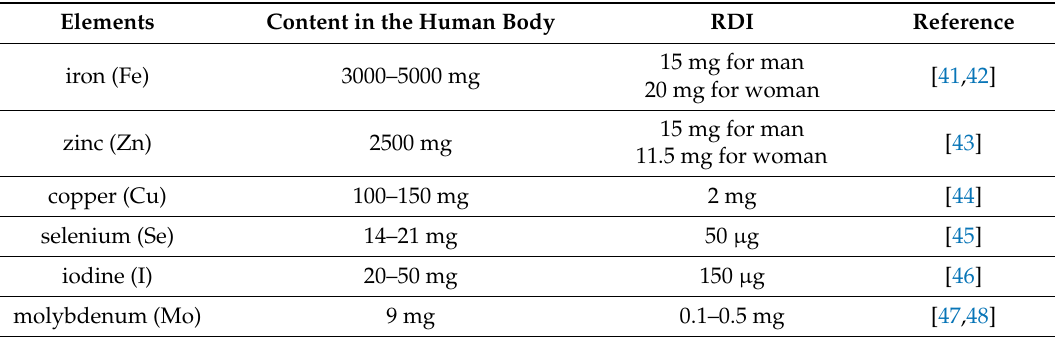
Table 1. Amount in and recommended daily intake of trace elements for